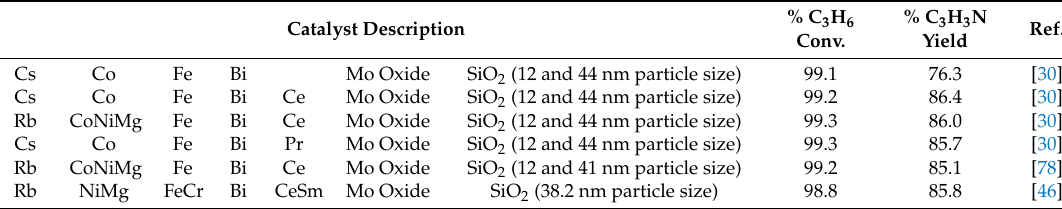
Table 4. Examples of using the catalyst design strategies herein for incorporating chemical and physical multifunctionality for propylene ammoxidation to